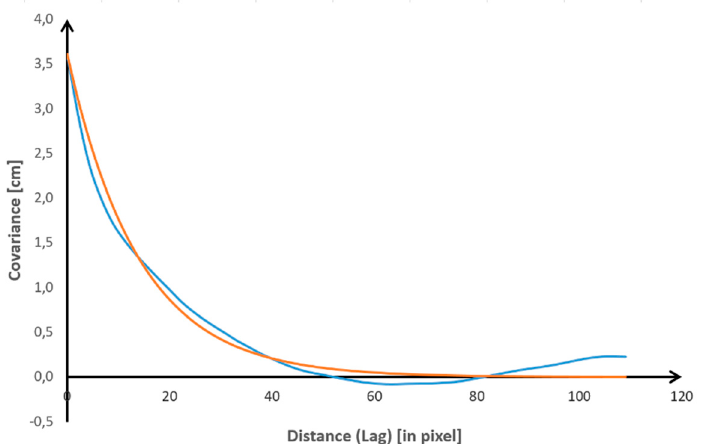
Figure 11. Empirical autocovariance function for Δ d residual deformations (blue) and the corresponding exponential model (red).